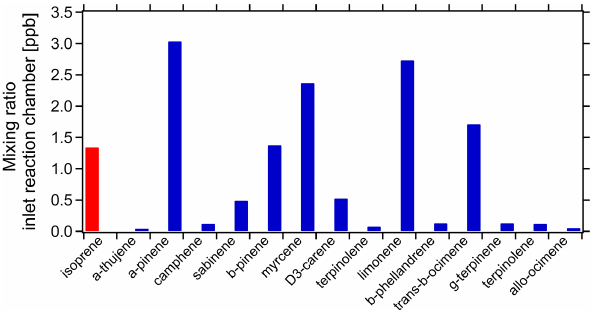
Fig. 2. BVOC mixing ratios at the inlet of the reaction chamber. Dilution by the second air stream is already considered, the sum of mixing ratios represents [BVOC] 0 . The plants in the plant chamber (two Aleppo pines, one holm oak, one Palestine oak, and one pis- tachio) constitutively emitted isoprene (red bar) and monoterpenes (blue